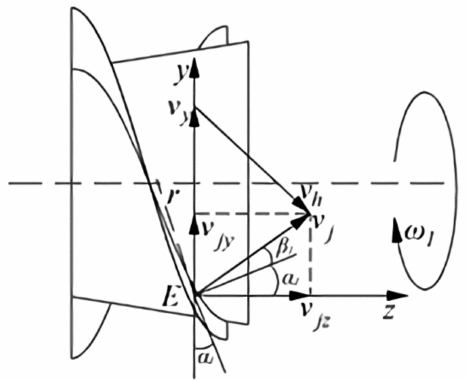
Figure 3. Grain speed analysis diagram of the feeding